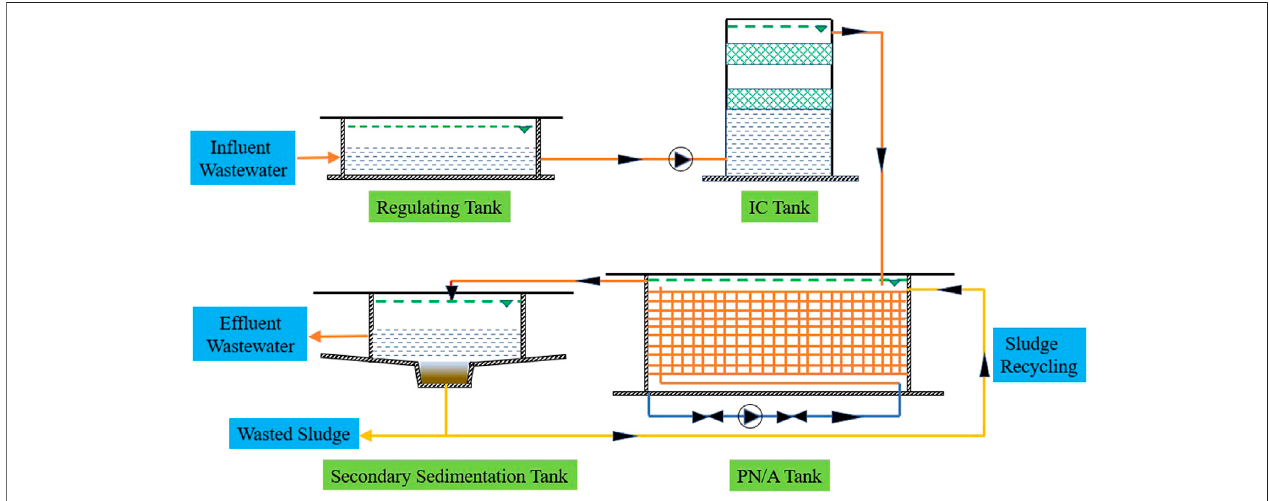
FIGURE 1 | Schematic diagram of the full-scale sidestream PN/A plant. IC means internal circulation. PN/A means partial nitri fi cation and anammox.